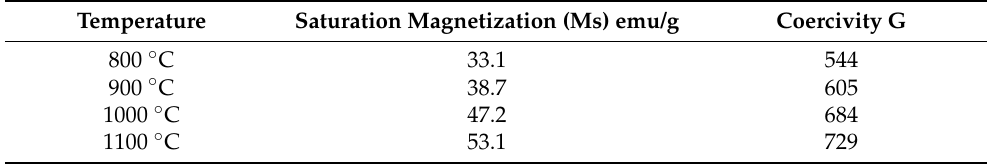
Table 3. Magnetization of gadolinium